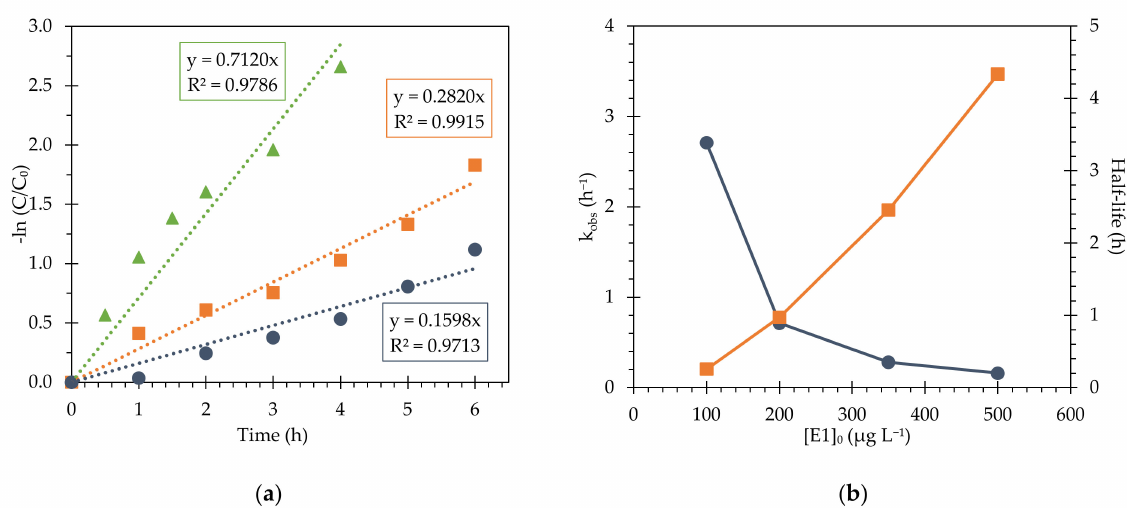
Figure 7. Pseudo-first order fit for E1 removal for ( a ) initial concentrations of 200 (blue circles), 350 (orange squares) and 500 µ g L − 1 (green triangles) and ( b ) kinetic constants (blue circles) and half-life (orange squares) obtained for the degradation experiments conducted at Fe concentrations of 750 mg L − 1 and H 2 O 2 at 300 mg L − 1 , at pH